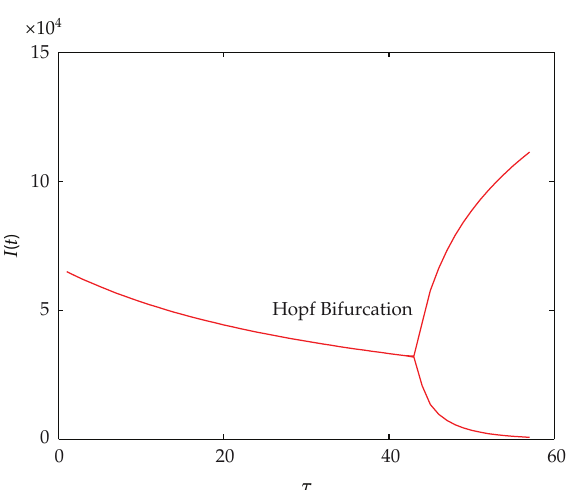
Figure 9: Bifurcation diagram of system (cid:5) 2.1 (cid:6) with τ from 1 to 60 without quarantine strategy.